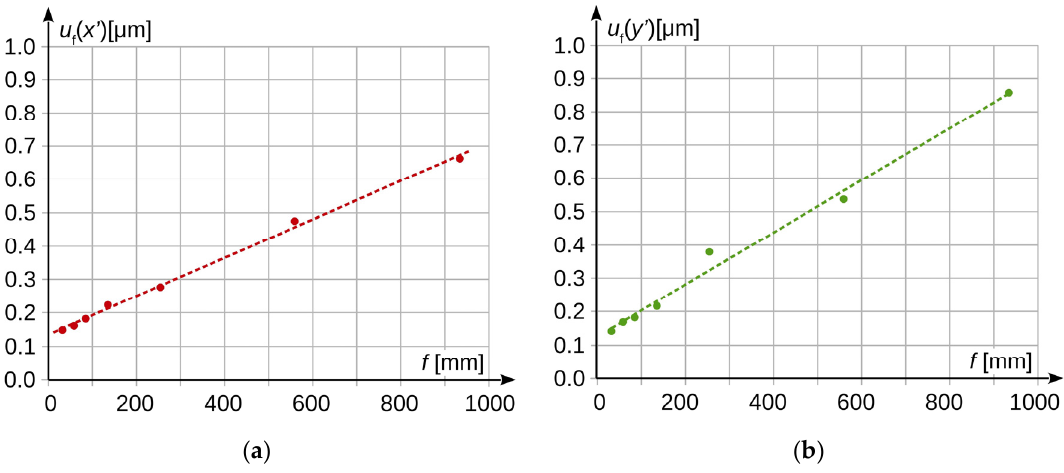
Figure 8. Standard measurement uncertainty as a function of lens focal length: ( a ) measurement results in the horizontal axis; ( b ) measurement results in the vertical axis.